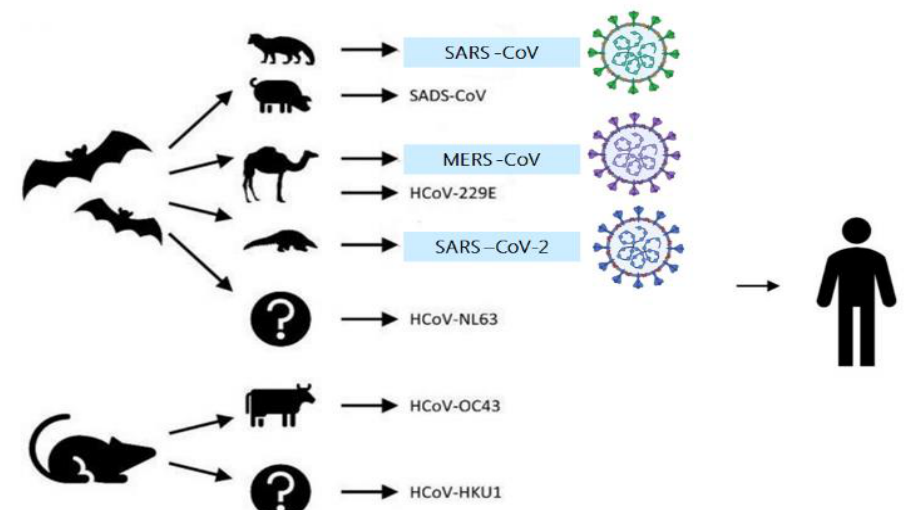
Figure 1. The animal origins of human coronaviruses (severe acute respiratory syndrome coronavirus (SARS-CoV), severe acute respiratory syndrome coronavirus 2 (SARS-CoV-2), and Middle East respiratory syndrome coronavirus (MERS-CoV)). Adapted from Rabi et al. [8], licensed CC BY 4.0. HCoV, as well as other types of viruses, including 229E, OC43, and NL63, generally infect the human upper respiratory tract [61], as presented in Table 1. Table 1. The animal origins of various coronaviruses, the corresponding diseases and some characteristics of them in comparison with influenza viruses a .